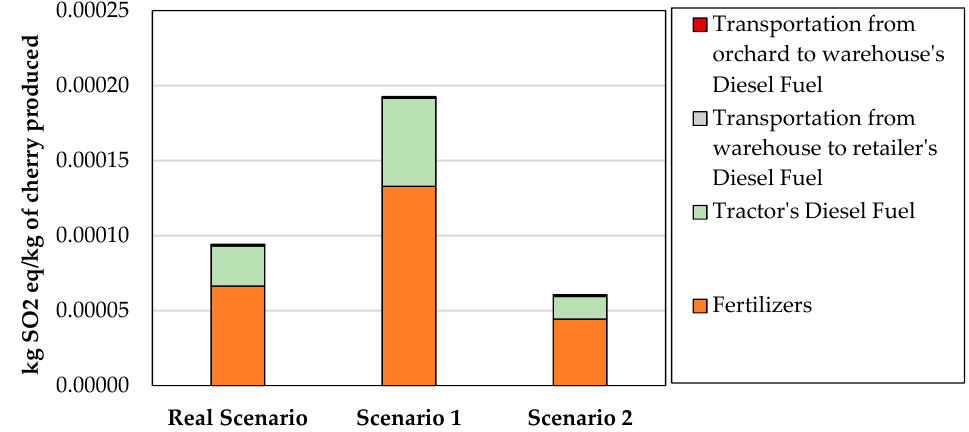
Figure 6. Terrestrial acidification for the FU of 1 kg of produced cherry for the real and test scenar-